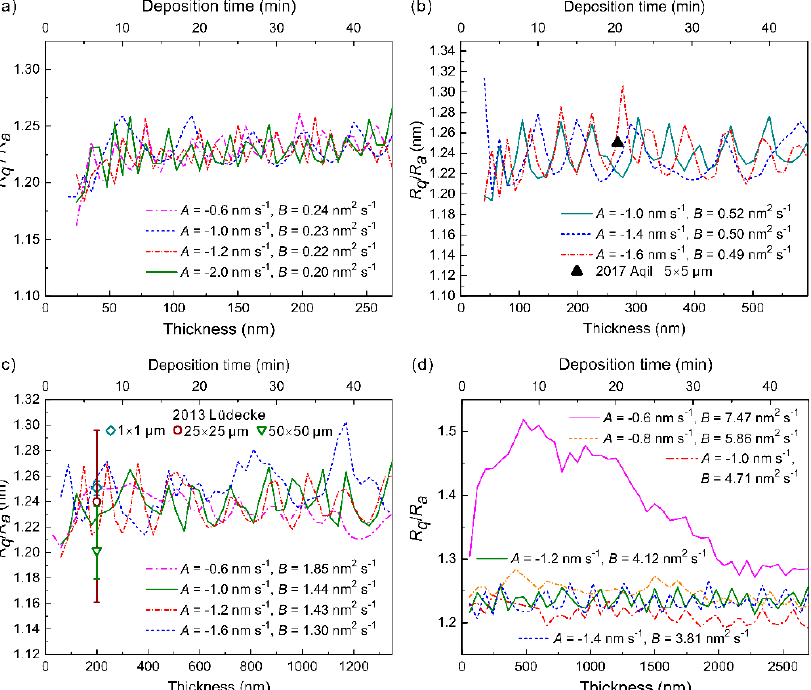
Figure 8. Ratios of R q to R a for thin films deposited at four different deposition rates of ( a ) 0.1 nm s − 1 , ( b ) 0.22 nm s − 1 , ( c ) 0.5 nm s − 1 , and ( d ) 1.0 nm s − 1 with the deposition thickness and deposition time, compared with the experimental data [2,3].